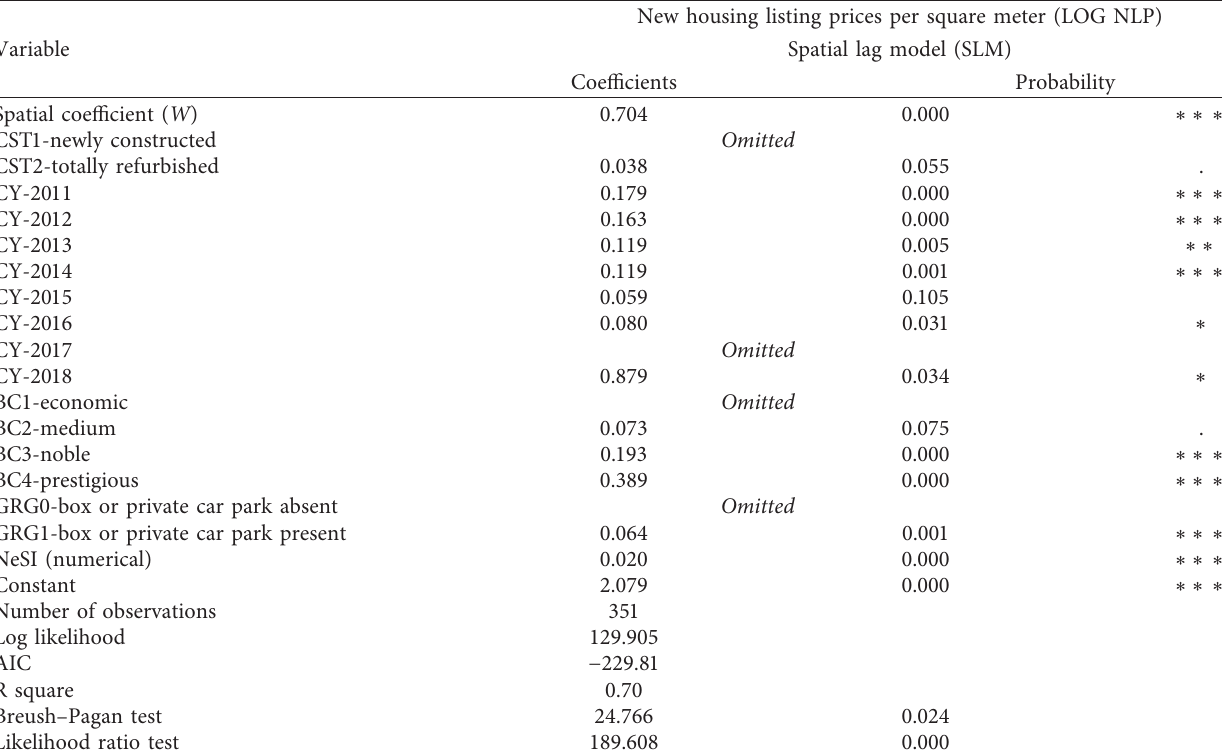
Table 4: Spatial lag model (SLM) to assess the relationship between NLP and extrinsic and intrinsic characteristics of the new housing stock (source: authors’